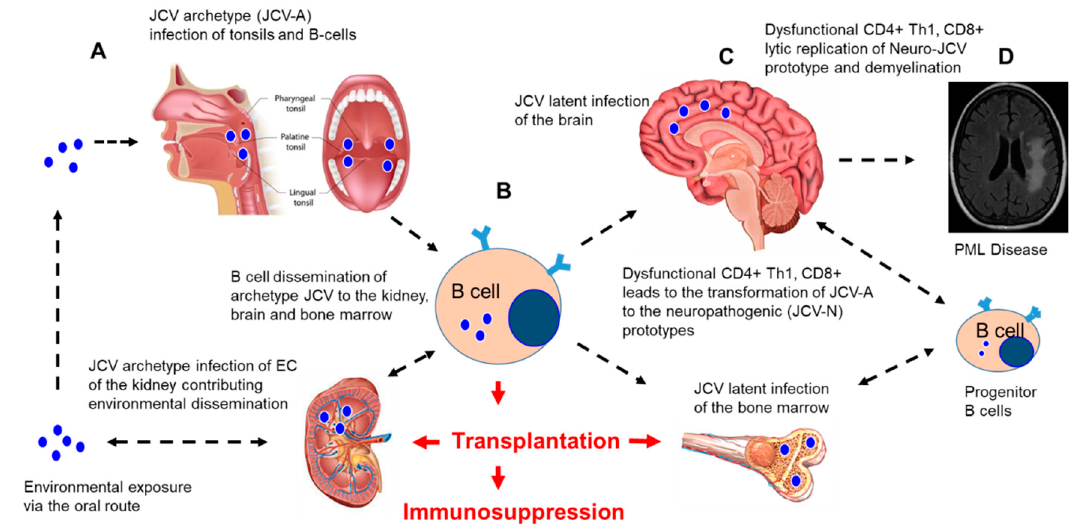
Figure 1. JC polyomavirus (JCV) infection and dissemination from environmental exposure to a latent infection and implications for immunosuppression after transplantation. A hypothetical model of JCV infection, latency, and